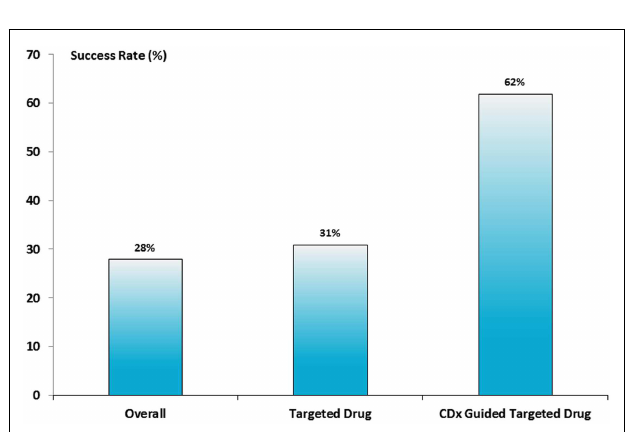
FIGURE 3 | Success rate for NSCLC drugs in phase III clinical trials . Based on the analysis of 676 clinical trials a success rate of 28% was found for all types of drugs, however, if the drug was either a receptor target drug or guided by a CDx assay the success rate increased to 31 and 62%, respectively